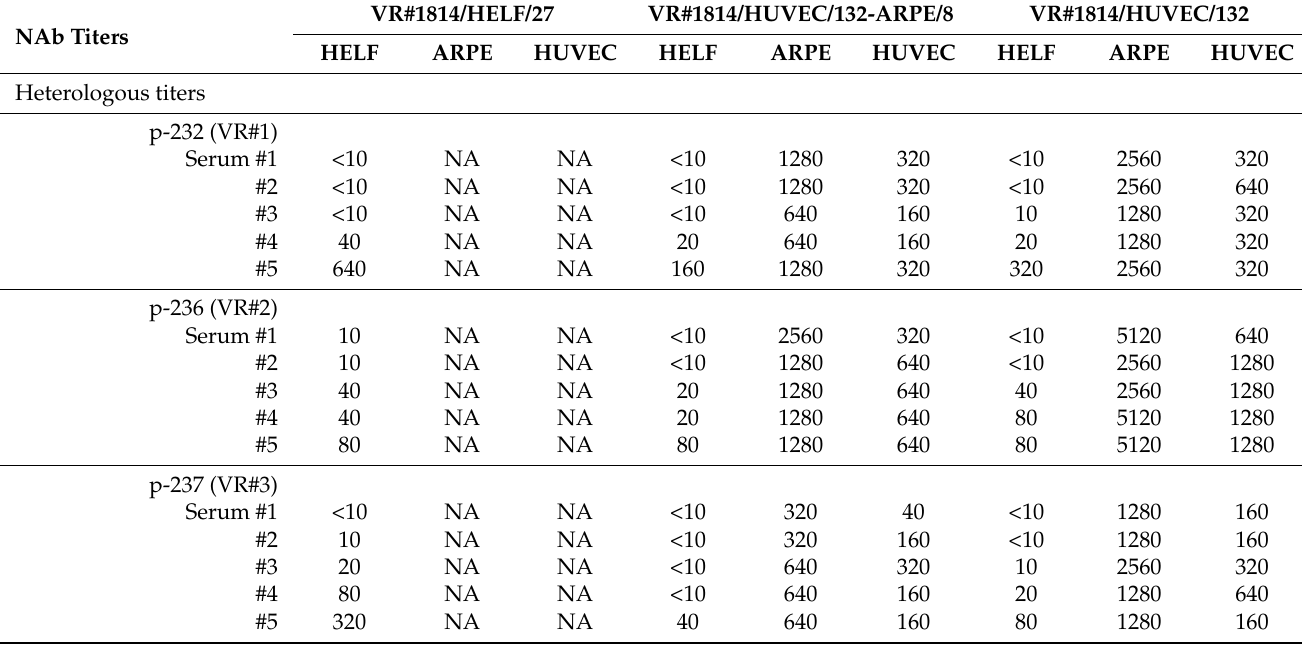
Table 4. Heterologous NAb titers of p-232, p-236 and p-237 vs.